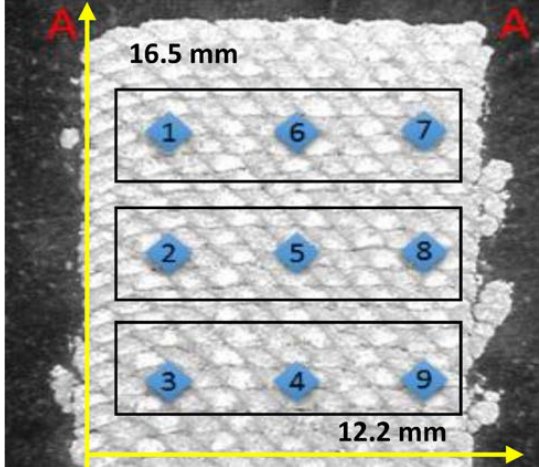
Figure 5. View of cross-sectional area (A-A from Figure 4) of samples in which three regions for measurements were selected (top, middle, and bottom) and the locations of each individual reading. J. Manuf. Mater. Process. 2018 , 2 , x FOR PEER REVIEW